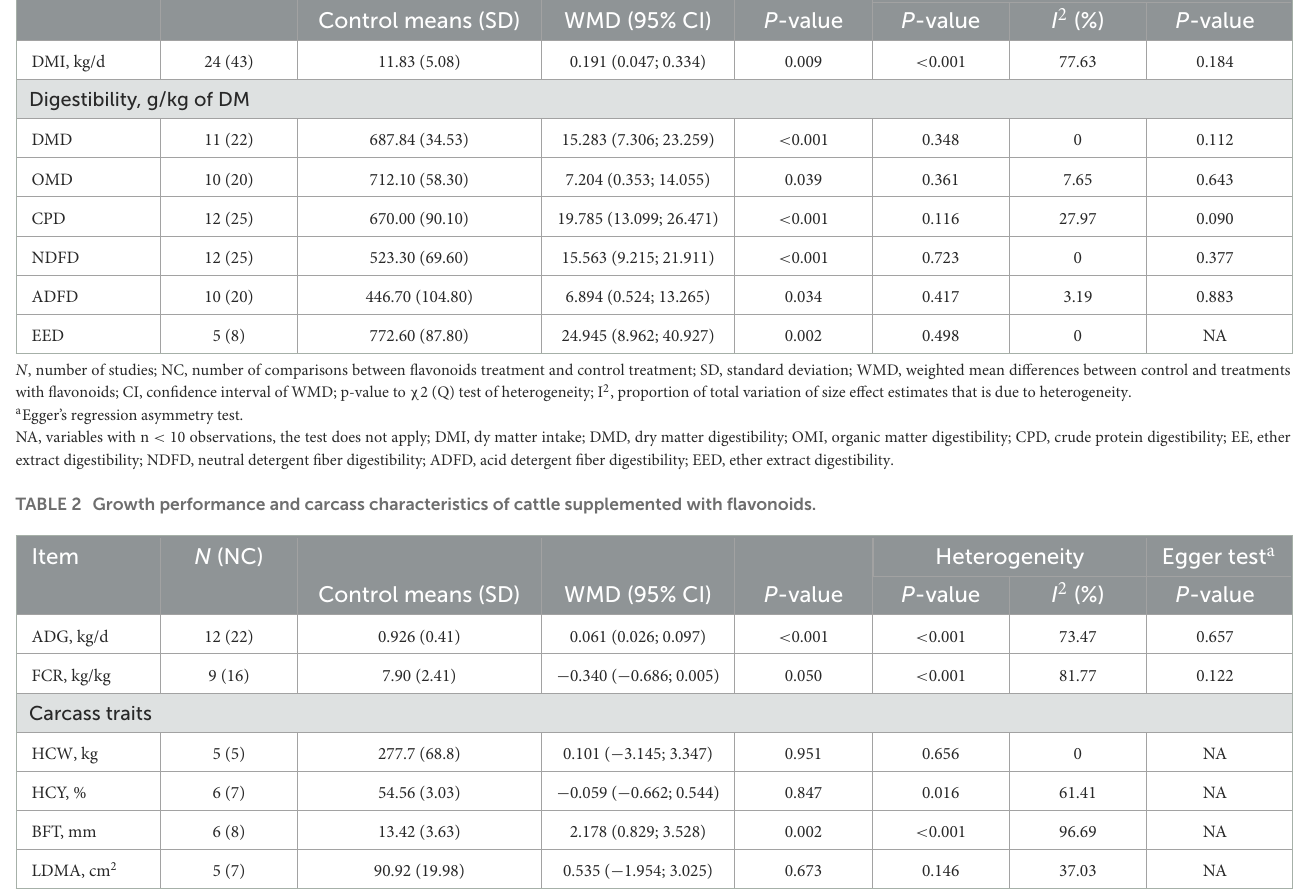
TABLE 1 Dry matter intake and nutrient digestibility of cattle supplemented with flavonoids. Item